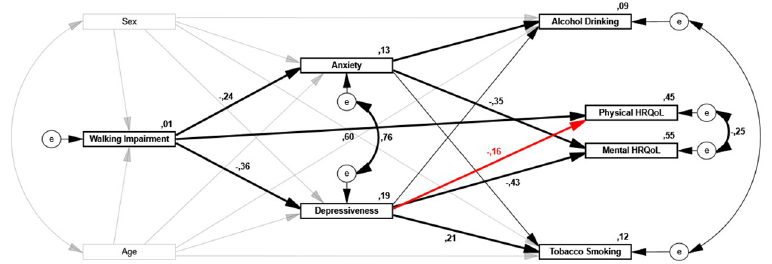
Fig 2. Final path analysis model testing the influence of walking impairment on mental burden, health risk behavior, physical and mental HRQoL in PAD patients (N = 1 687). The numbers on the arrows are standardized regression coefficients ( β ) that indicate the magnitude of effects between variables (coefficients < .10 not shown). Pathways are represented by thick lines, pathways that were constrained to 0 due to model respecification are represented by thin lines. Grey lines represent added covariates to the model (i.e. age, sex) for adjustment of confounding (coefficients not shown; see Table 2). The numbers above the boxes indicate the total proportion of variance explained in the model (R 2